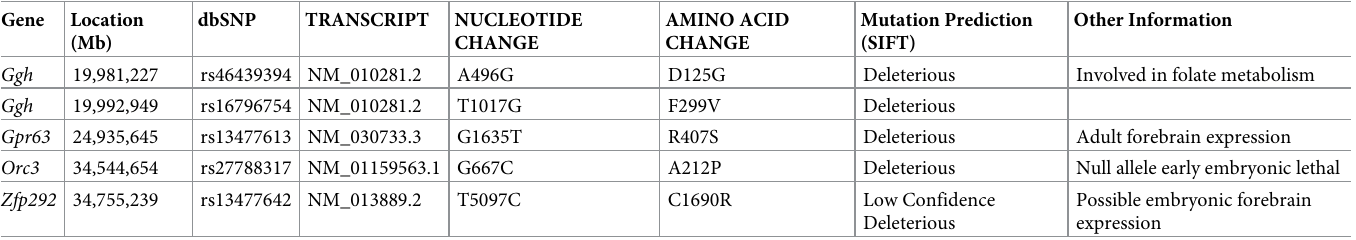
Table 3. Candidate Moaq1